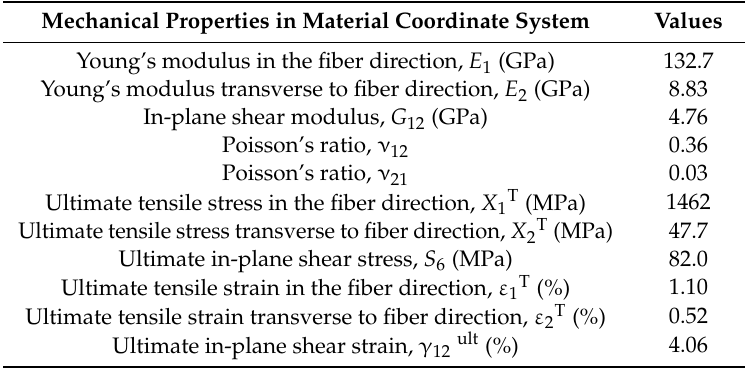
Table 1. In-plane mechanical properties of the UD carbon-fiber / epoxy composite laminate made of Hexcel T2G190 / F263 prepregs